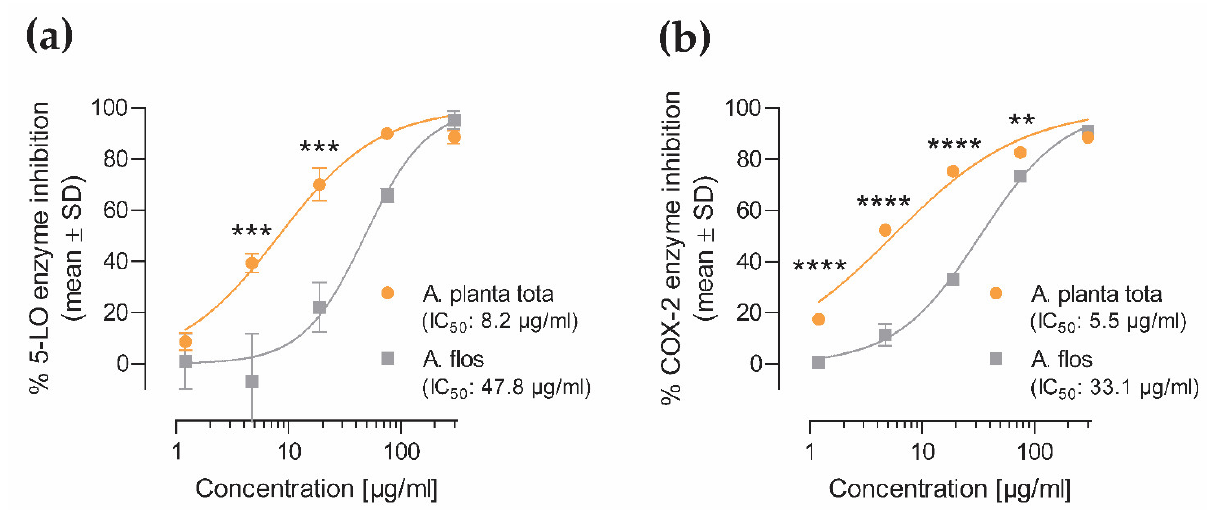
Figure 4. Inhibition of 5-LO ( a ) and COX-2 ( b ) in vitro enzymatic activity by Arnicae planta tota and Arnicae flos. The inhibitory effect of increasing concentrations of Arnicae planta tota and Arnicae flos on the enzymatic activity of human 5-lipoxygenase (5-LO) and cyclooxygenase-2 (COX-2) was tested using cell-free enzymatic assays. Data are expressed as the percentage of enzyme inhibition relative to vehicle. Data are given as mean ± SD of two biological replicates from one representative experiment out of two independent experiments. Differences in enzyme inhibition between Arnicae flos and Arnicae planta tota for each extract concentration was tested using a two-way ANOVA with Bonferroni’s correction for multiple comparisons (**, p < 0.01; ***, p < 0.001; ****, p < 0.0001). Abbre-